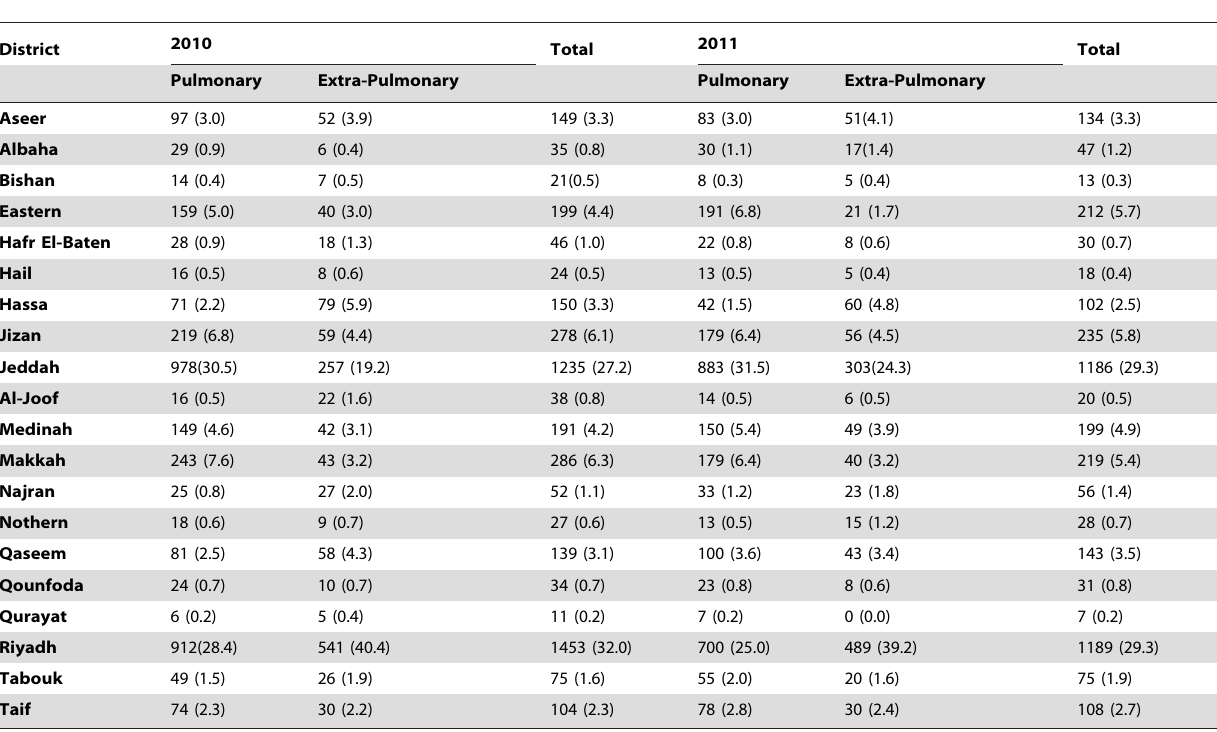
Table 4. The distribution of new tuberculosis patients in Saudi Arabia Province/District (Health Affairs) by type 2010–2011.